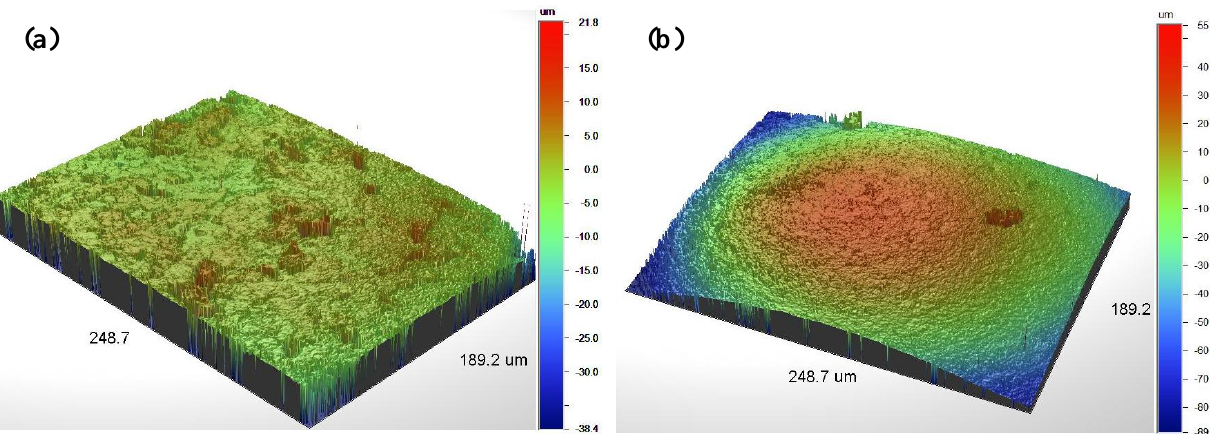
Figure 5. Interferometric profilometry of the ( a ) carbon and ( b ) Ag/AgCl surfaces (at 25× magnification in each